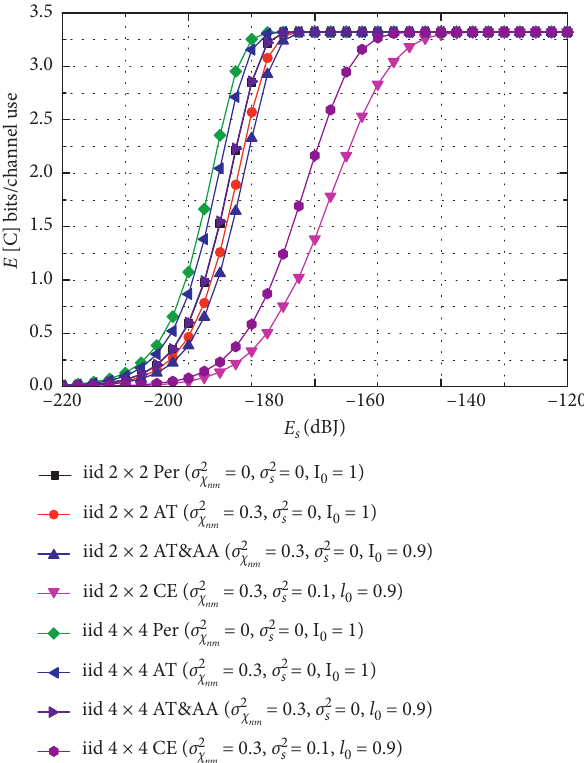
Figure 9: Ergodic channel capacity with different conditions over independent channel.